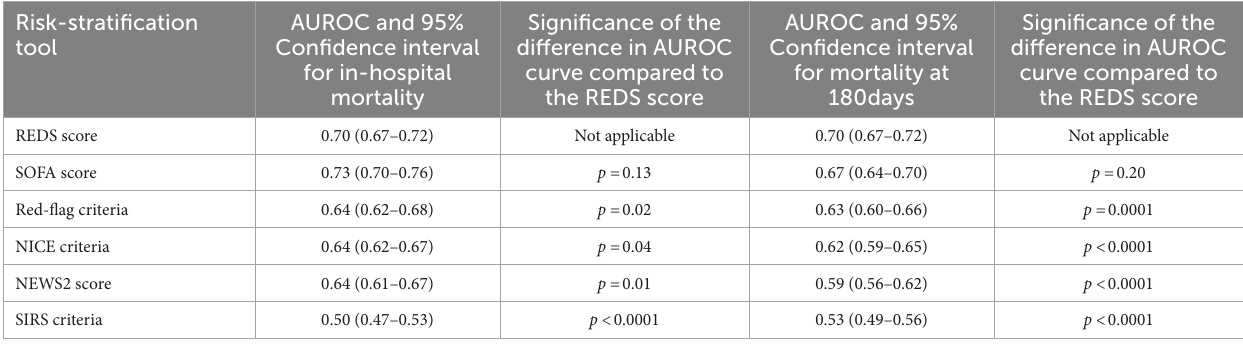
TABLE 4 Area under receiver operator characteristic (AUROC) curve for mortality at hospital discharge and at 180 days for all risk-stratification tools; and the significance of the difference when compared with the AUROC curve of the respective REDS score. Risk-stratification tool